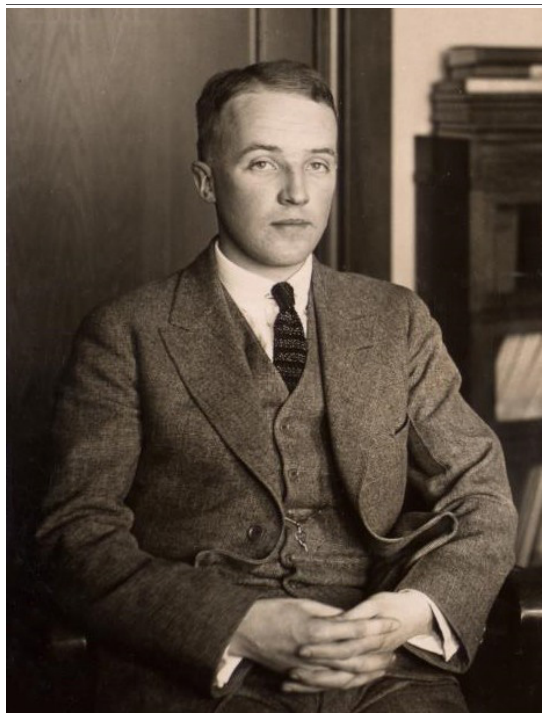
Figure 2. Charles Herbert Best (27 February 1899 – 31 March